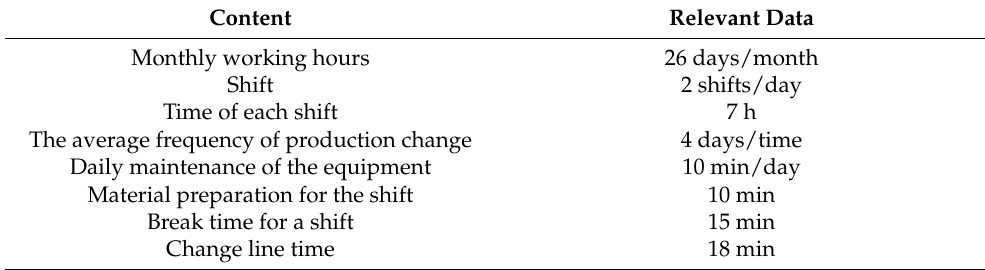
Table 1. Working Rule of Workshop.